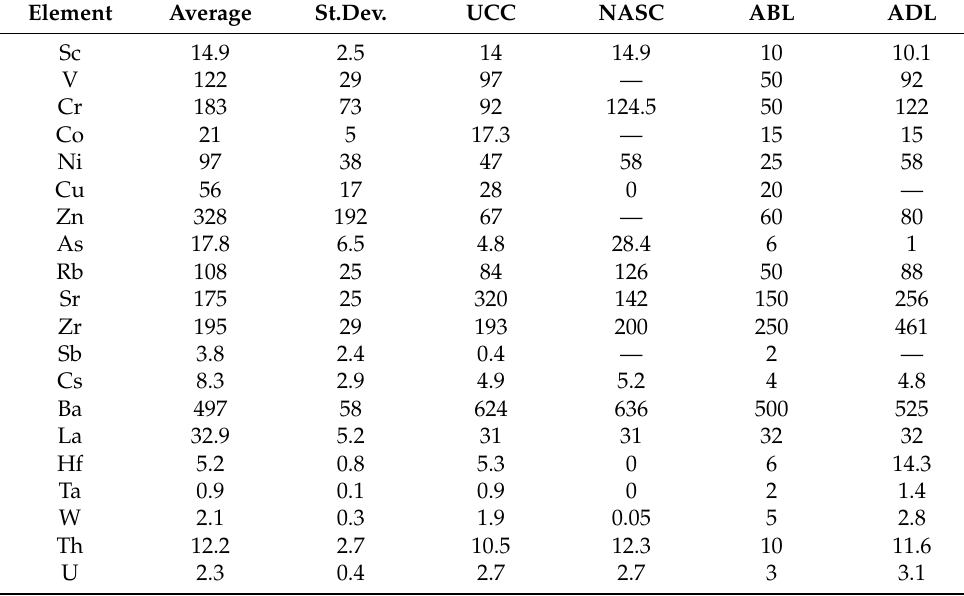
Table 2. The experimental average values ± one standard deviation (St.Dev.) of trace elements’ mass fractions together, with corresponding values of UCC [22], NASC [23], ABL [24] and ADL [25]. All mass fractions are expressed in mg/kg. Element